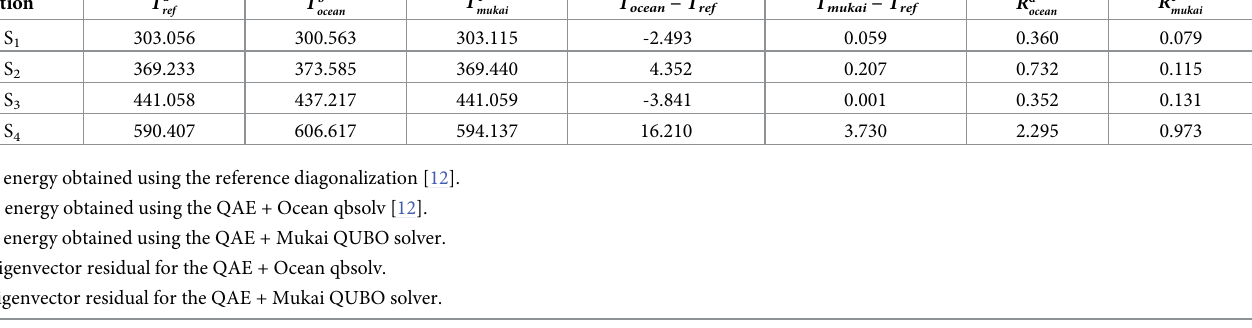
Table 2. Electronic transition energies of the H 2 O molecule computed using the QAE and FCI/STO-3G matrix in kcal/mol.